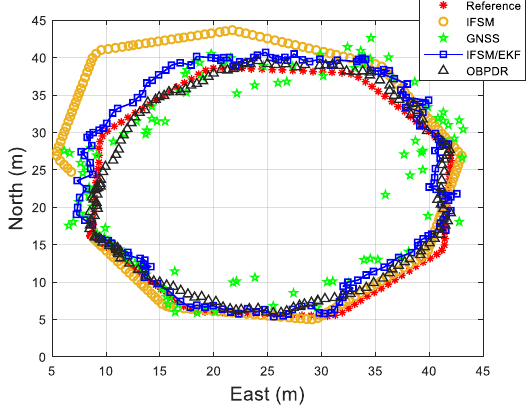
Figure 14. The positioning results of fountain experiment.